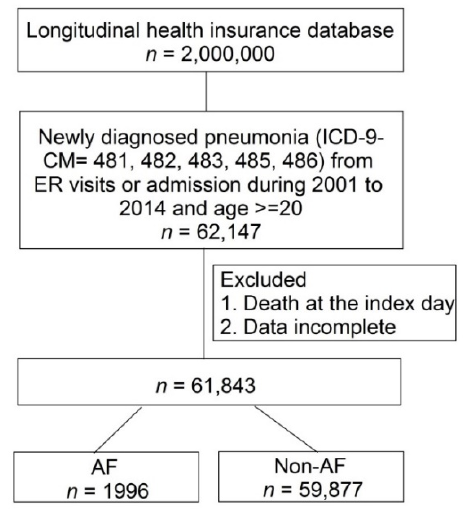
Figure 1. Flow chart of patient selection. The baseline characteristics, comorbidities, and medication usage of patients with pneumonia in the AF and non-AF groups are shown in Table 1. Compared with the patients with pneumonia in the non-AF group, those in the AF group were significantly older (78.1 ± 10.8, vs. 59.3 ± 20.8), with more comorbidities such as dyslipidemia, chronic kidney disease, chronic obstructive pulmonary disease, and a higher CHA2DS2-VASc score (4.3 ± 1.7 vs. 2.1 ± 1.8). The incidence density of MACE was 2054 (per 1000